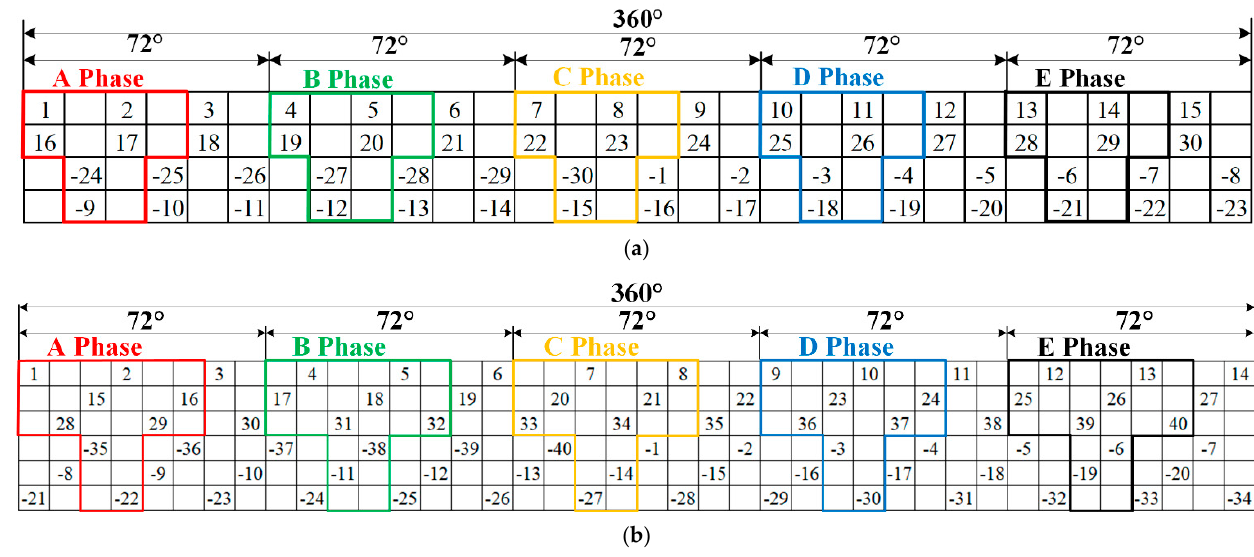
Figure 2. SNPD of five − phase fractional slot size phase − belt winding. ( a ) M1 motor; ( b ) M2 motor.